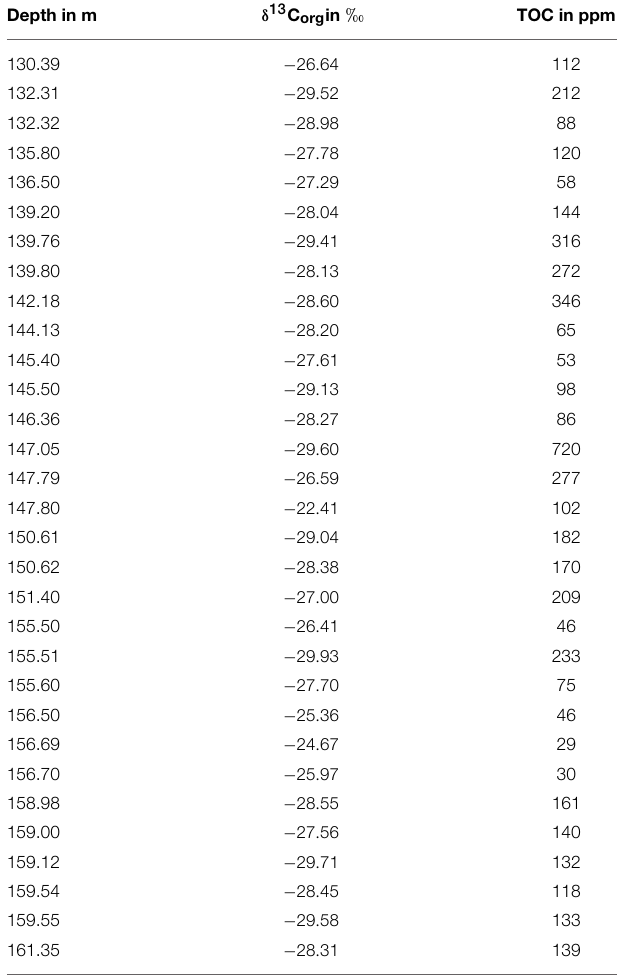
TABLE 1 | δ 13 C org and Total Organic Carbon (TOC) data for TCDP-1 from 130.39 to 161.35m depth.